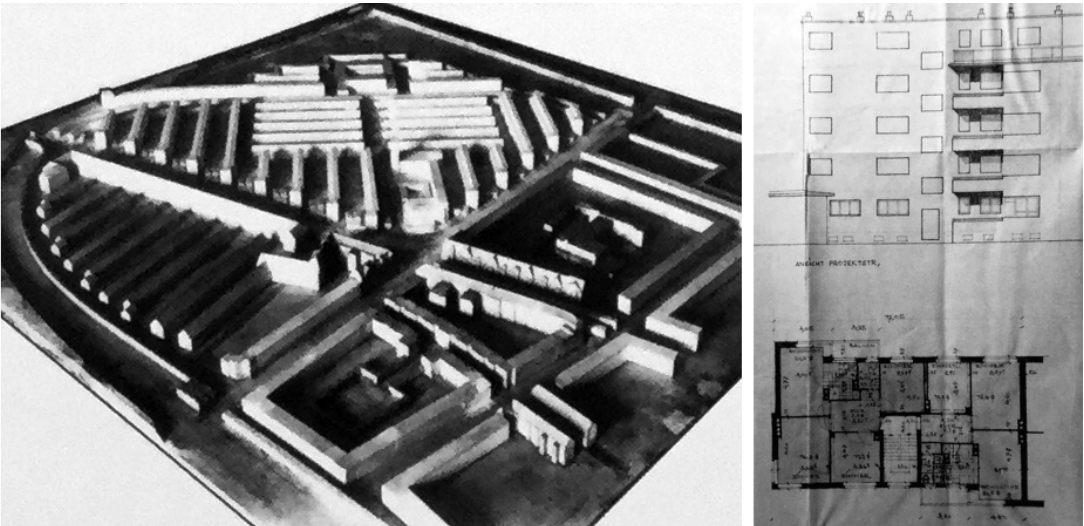
Figure 15. From left to right: W. Riphahn, Cologne-Buchforst, Siedlung Kalkerfeld with Blauer Hof and Weisse Stadt (1929–1930; Mantz, 1928); Cologne-Buchforst, Siedlung Kalkerfeld with Blauer Hof and Weisse Stadt (1929–1930; Schmölz, 1929).